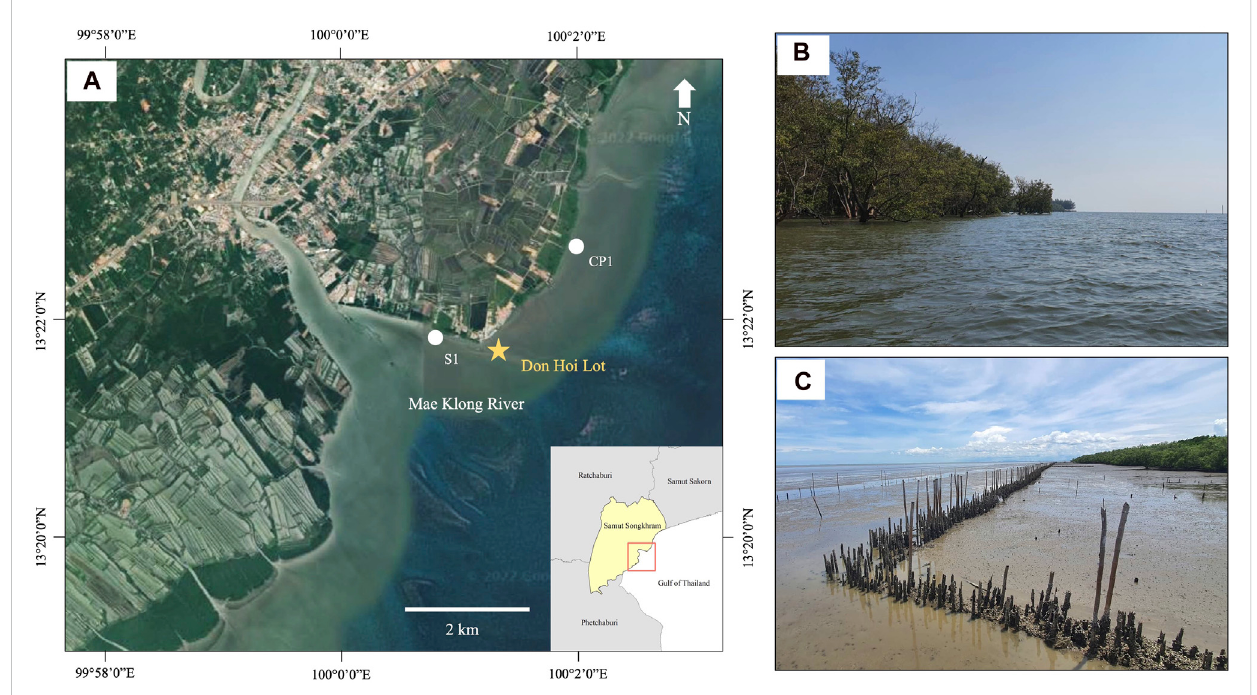
FIGURE 1 Study area. (A) Location of the Mae Klong River mouth on the upper gulf of Thailand. (B) Landscape of the S1 site located near Don Hoi Lot. (C) Landscape of the CP1 site located on the east side of the Mae Klong River